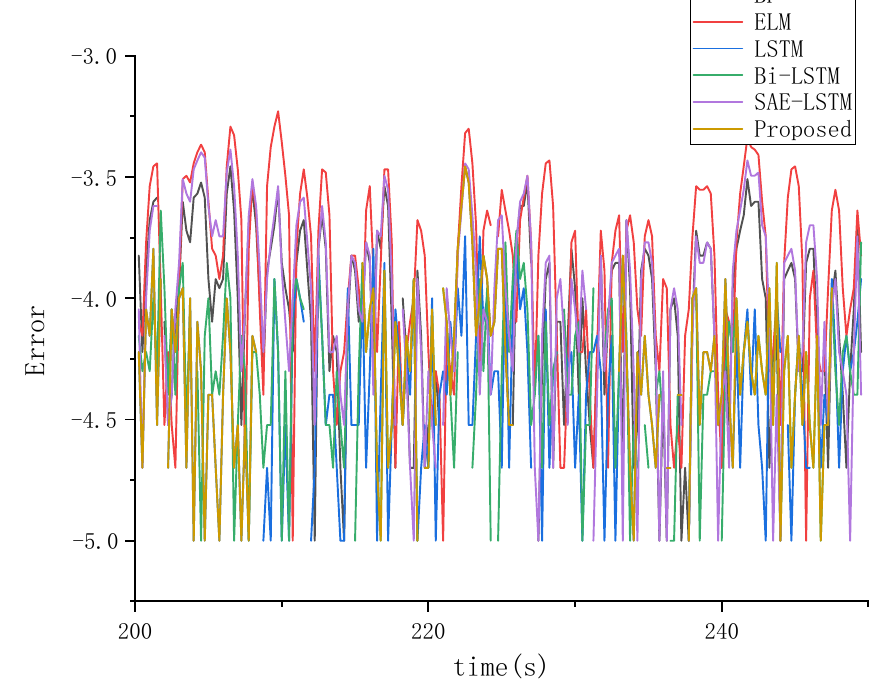
Figure 15. Roll angle prediction error results in the testing set of Dataset